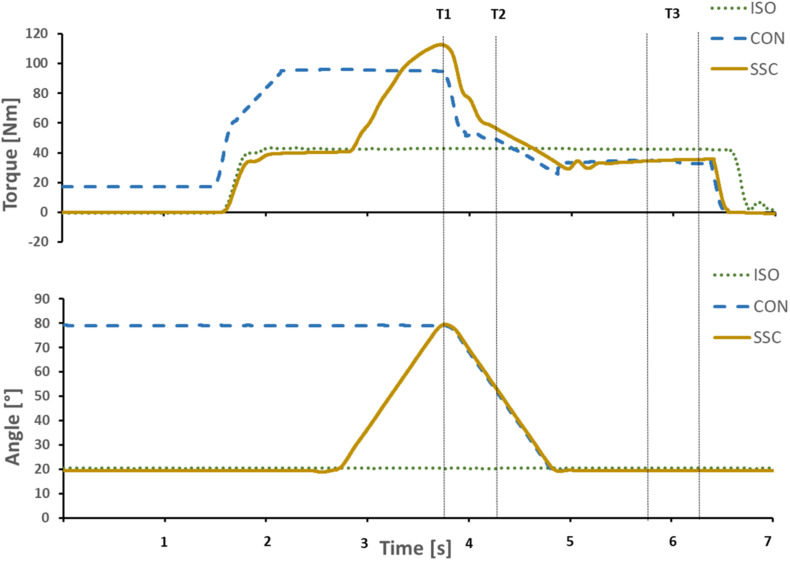
Exemplary representation of torque-time and angle-time traces. Vertical lines indicate the time point at the end of stretch (T1), midpoint of shortening (T2), and the steady-state interval where the mean steady-state torque was calculated (T3). Continuous yellow line SSC, dotted green line ISO, and dashed blue line CON.